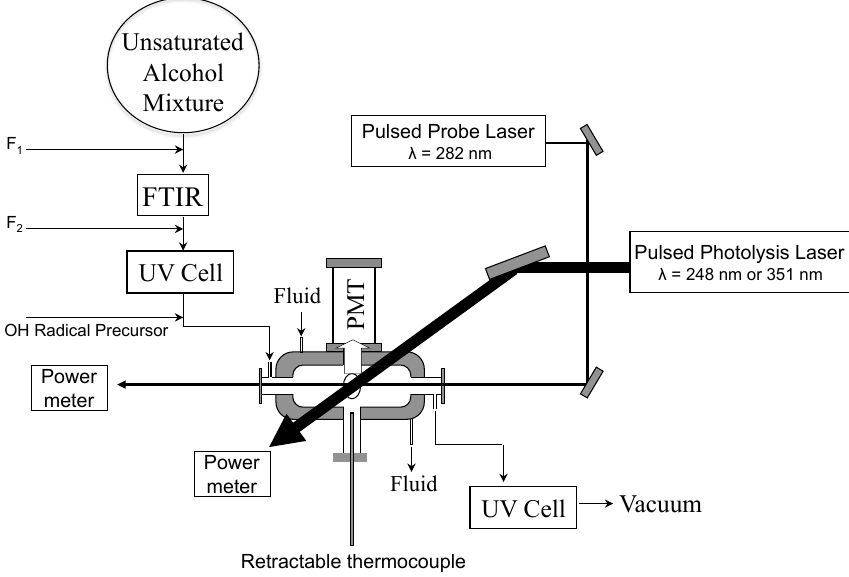
Fig. 1. Schematic of the pulse laser photolysis-laser induced fluorescence (PLP-LIF) apparatus. F 1 and F 2 indicate bath gas